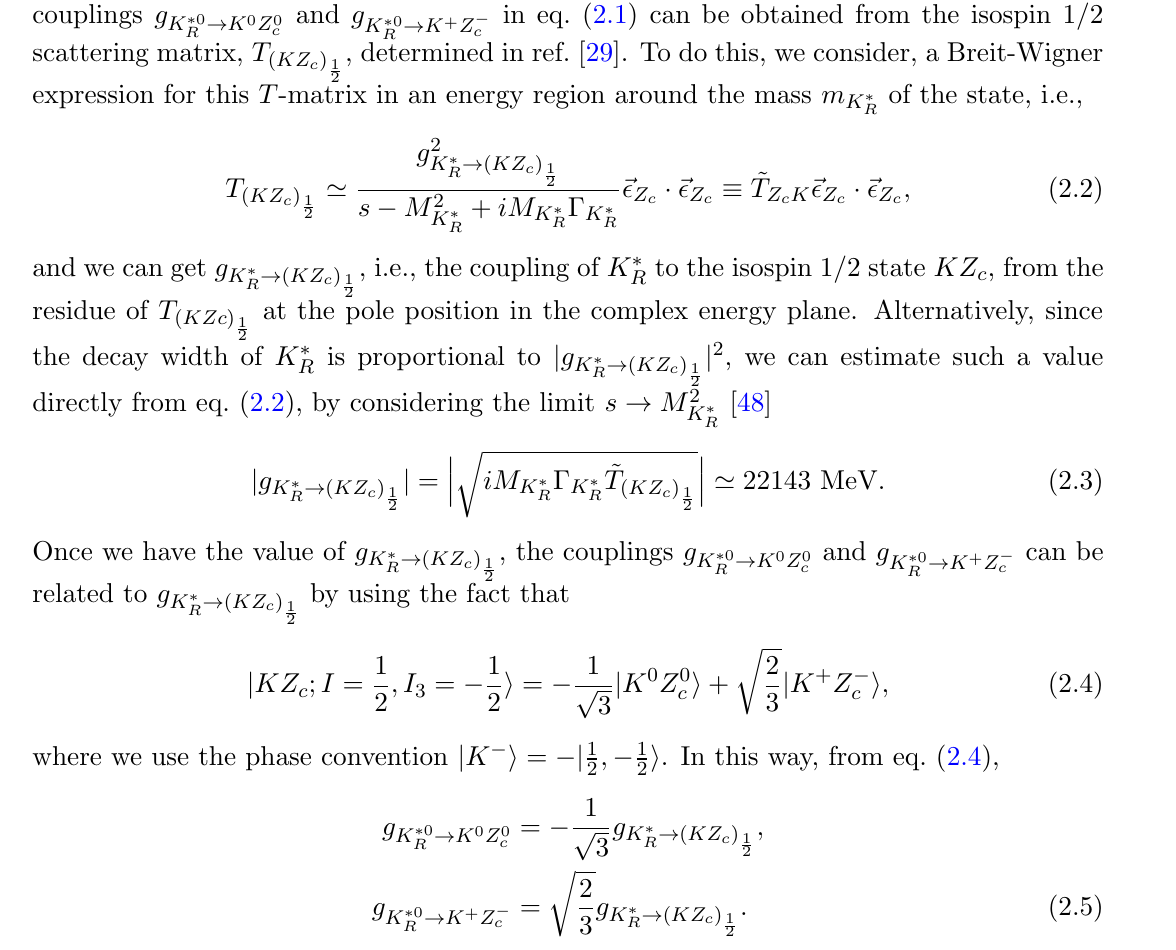
respectively, and the coupling of K (cid:3)